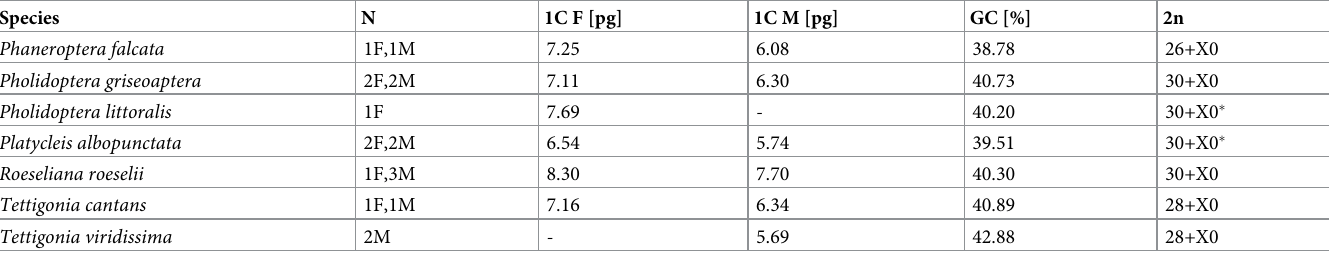
(p � 0.05) or highly significant (p � 0.001, in the case of 2n = 22 and 2n = 32) for all pairwise comparisons of chromosome numbers of 2n = 16 with any other chromosome numbers except 2n = 14 and 2n = 18, and for most pairwise comparisons of 2n = 22 (Table 3). The genome size differences between sexes are given in Table 4, including 83 species. The highest genome size differences were detected within four species of Acrididae (all 2n = 16 +X0)–with maximum of 2.52 pg in Gomphocerippus rufus (1C (male) = 10.66 pg), followed by Chorthippus vagans (2.43 / 8.68 pg), Pseudochorthippus parallelus (2.25 / 10.89 pg), and Schisto- cerca gregaria (2.13 / 8.55 pg). The next largest differences in the genome size were found in Tettigoniidae–with maximum of 1.75 pg in Deracantha onos (1C (male) = 17.39 pg, 2n = 28 +X0). Expectably, we found a significant correlation between larger genome size differences between sexes and larger male genome sizes (p = 0.005 � ). The difference in genome size between female and male (XX/X0) can be interpreted also as the size of the sex chromosome X. Negative size differences, i.e., larger genome sizes of males than of females, were detected in Myrmeleotettix maculatus (Acrididae; 1C (male) = 12.14 pg, 2n = 16+X0) with -0.31 pg and Chorthippus dorsatus (Acrididae; 1C (male) = 12.80 pg, 2n = 16+X0) with -0.21 pg. We found genome size and GC content highly correlated in both females (p = 5.924E -12 ) and males (p = 9.597E -06 ), with smaller genomes mostly having lower GC content. The GC content range was 35.86%-43.17% (N = 57, mean = 40.63 ± 1.61%) for females and 35.58%- 44.21% (N = 46, mean = 40.56 ± 1.59%) for males. Conspecific female and male GC content did not differ significantly (p = 0.826). The ANOVA test of differences of GC content among the families Acrididae, Tetrigidae, Gryllidae, and Tettigoniidae was highly significant (p = 5.965E - 29 ), and all pairwise Mann-Whitney tests (Bonferroni corrected) among these families were significant or highly significant, except between Tetrigidae and Gryllidae (Table